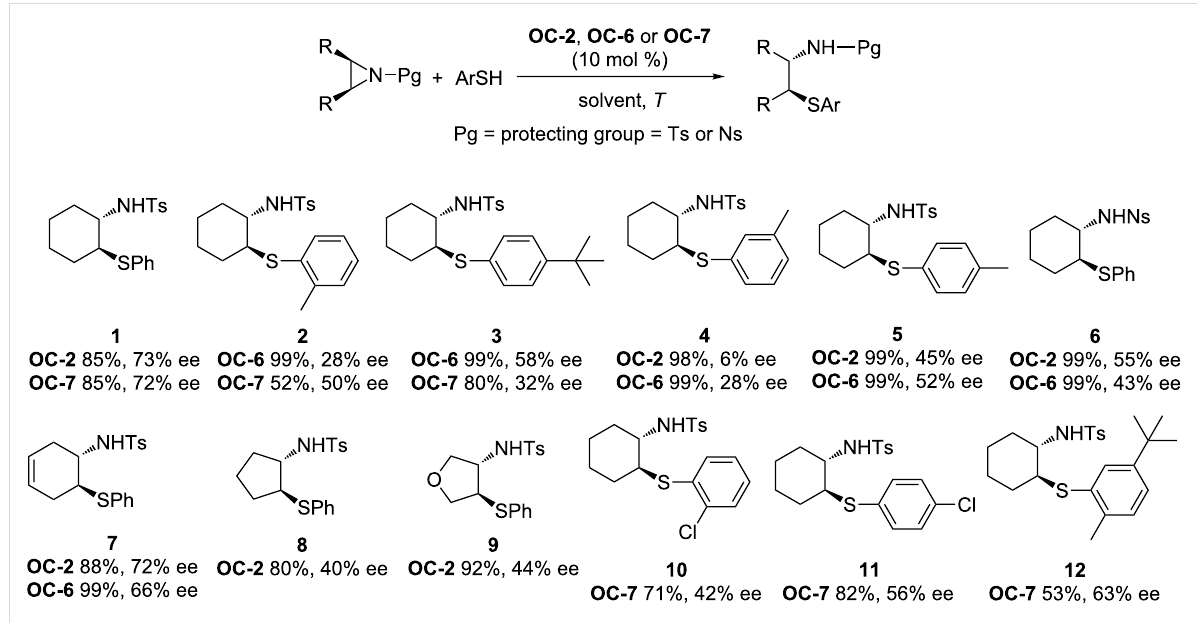
Figure 3: Cinchona alkaloid-derived catalysts OC-12 to OC-19 .